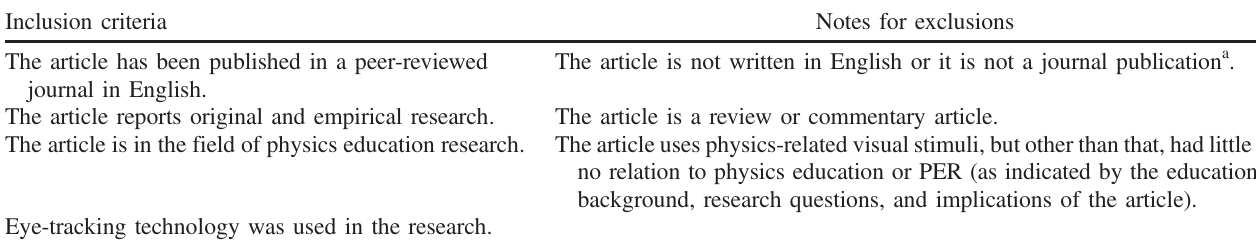
TABLE I. Inclusion criteria and notes for exclusions. Inclusion